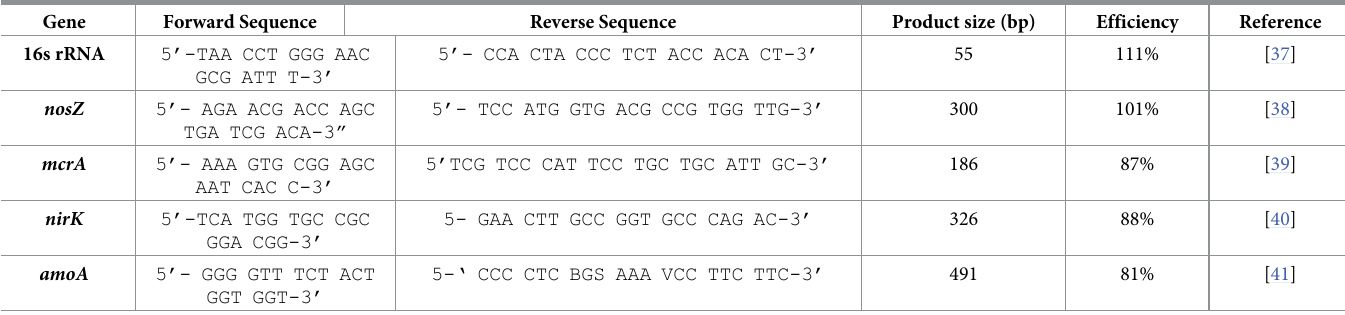
Table 3. Primers used in the functional gene abundance qPCR assay. Gene Forward